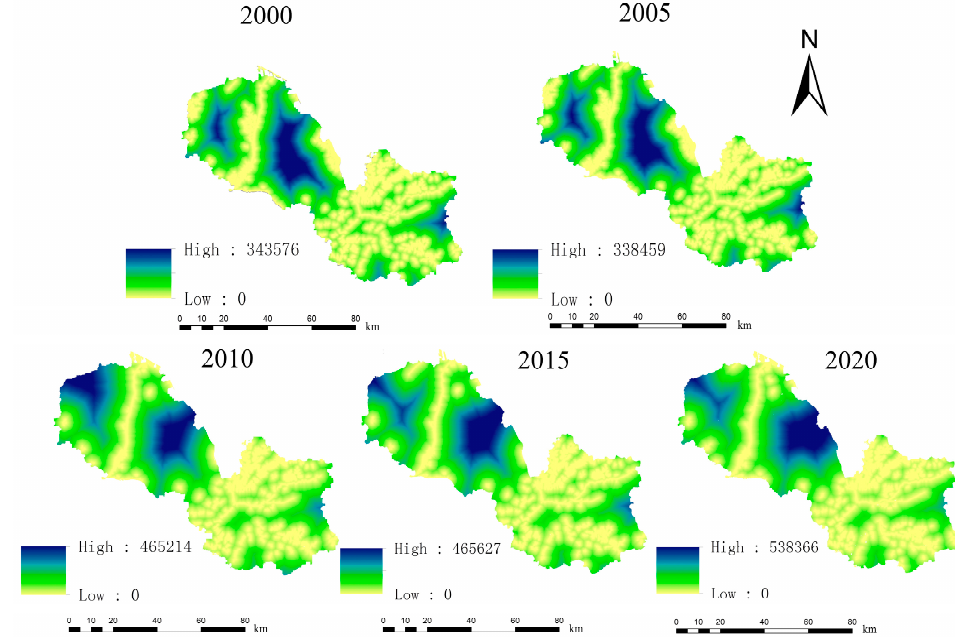
Figure 6. Cumulative resistance surface 2000–2020.